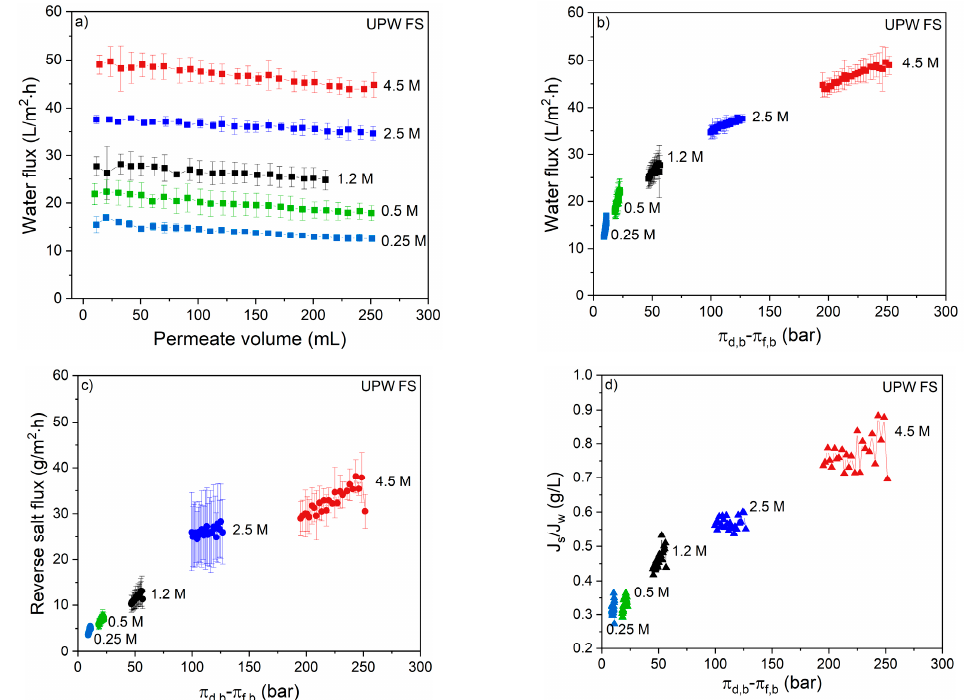
Figure 1. Membrane performance with various DS concentrations and UPW as FS in terms of ( a ) water flux as a function of permeate volume and ( b ) osmotic pressure difference; ( c ) reverse salt flux as a function of osmotic pressure difference and ( d ) specific reverse salt flux as a function of osmotic pressure difference between bulk DS and FS. Average values represent two runs.